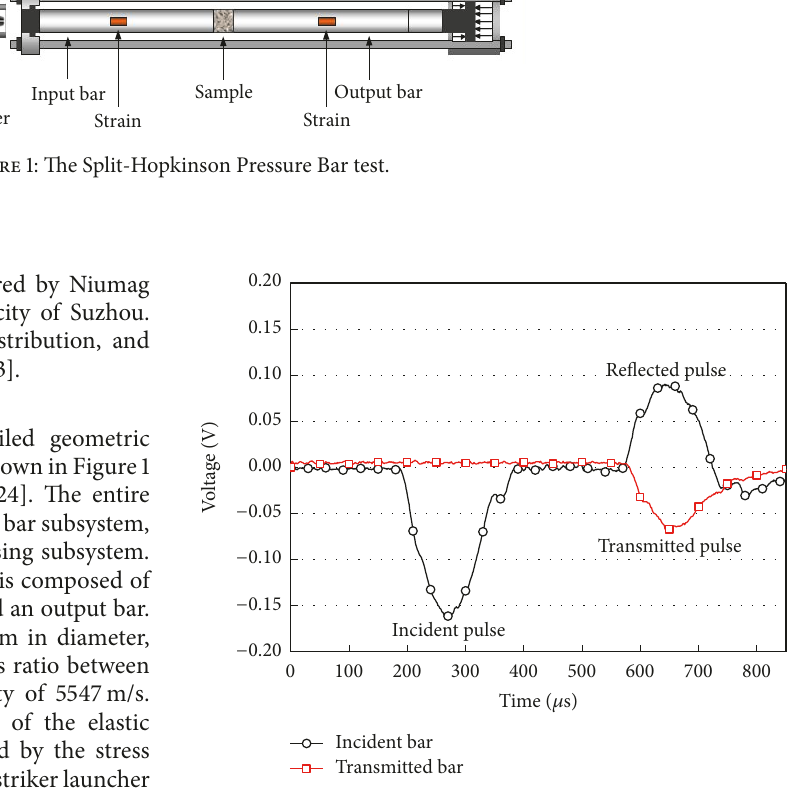
Figure 2: Incident wave, reflected wave, and transmitted wave in the bars in the dynamic